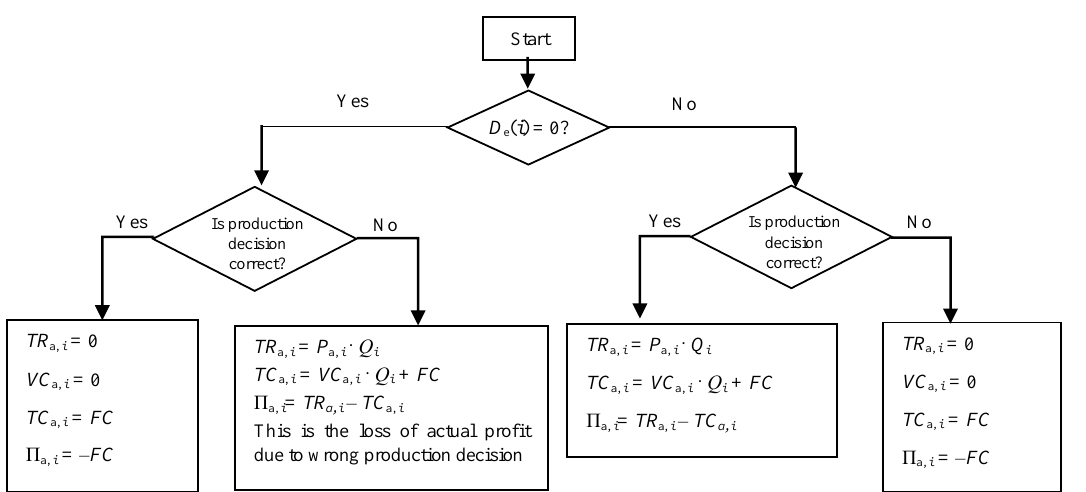
Fig. 2. Chart flow for calculation of the actual profit/loss, where TC a, i is the actual total costs of electricity production during the hour i ; VC a, i is the actual variable costs during the hour i ; TR a, i is the actual revenue during the hour i ; P a, i is the actual electricity price during the hour i ; Π a , i is the actual profit/loss during the hour i .